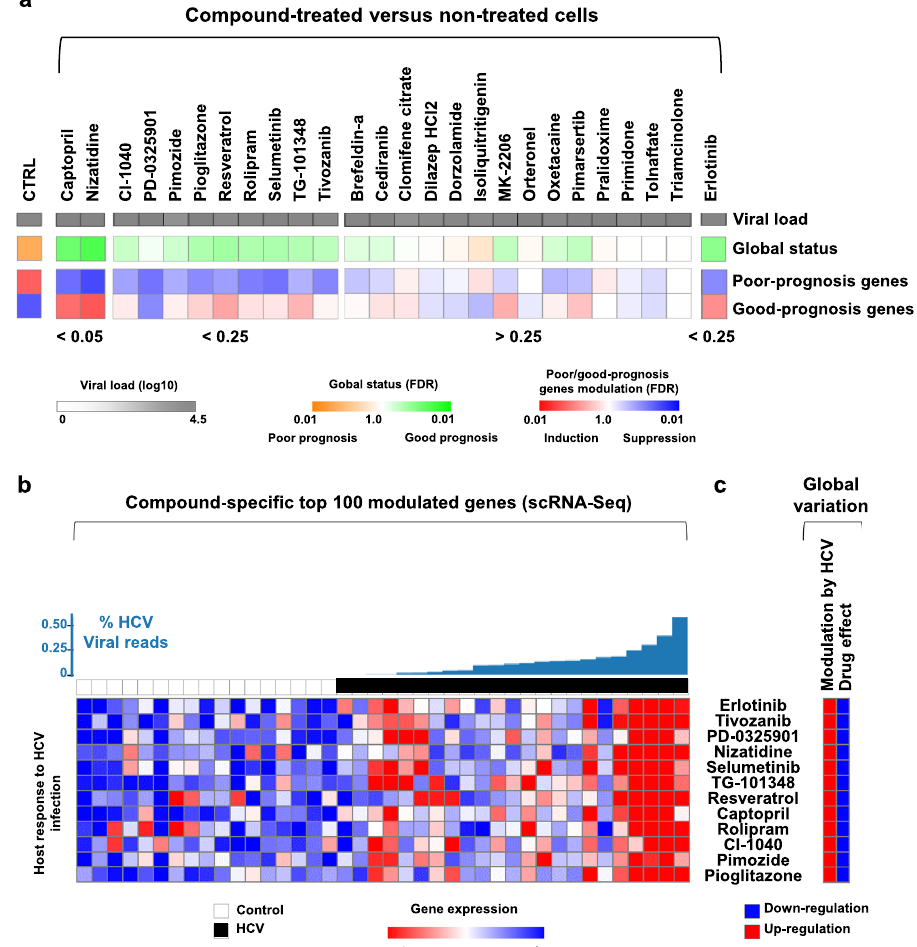
Fig. 2 A high-throughput screen with the clinical PLS as a readout identi fi es nizatidine as candidate compound for treatment of chronic liver disease and HCC prevention. a Effect of computationally selected compounds on the PLS. Simpli fi ed heatmaps show the HCV viral load after drug treatment (log 10), PLS global status, and PLS poor- and good-prognosis gene expression. PLS induction was determined by GSEA analysis using “ mock ” non-infected cells as reference control. Reversal of the PLS was assessed by comparing “ HCV-infected cells treated with compounds ” versus “ HCV-infected cells (CTRL) ” . The compounds were then ranked depending on the FDR (signi fi cant FDR < 0.25). Results from drug screening performed in triplicate are shown. b Screen hit target genes modulated by HCV infection at the single-cell level. Gene signatures comprising the targets of each speci fi c compound were extracted from the LINCS database and tested for their enrichment in association with the HCV viral load. Heatmaps show the mean expression of the leading-edge genes for the signi fi cantly enriched signatures ( p < 0.05) in each of the single cells (columns), row normalized as z -score. The single cells are ordered by infection status (white: non-infected cells, n = 17; black: infected cells, n = 23), and by increasing HCV viral load (blue bar plot on top). c Global modulation of the compound-speci fi c gene signatures by HCV infection and drug treatment. Source data are provided as a Source data fi